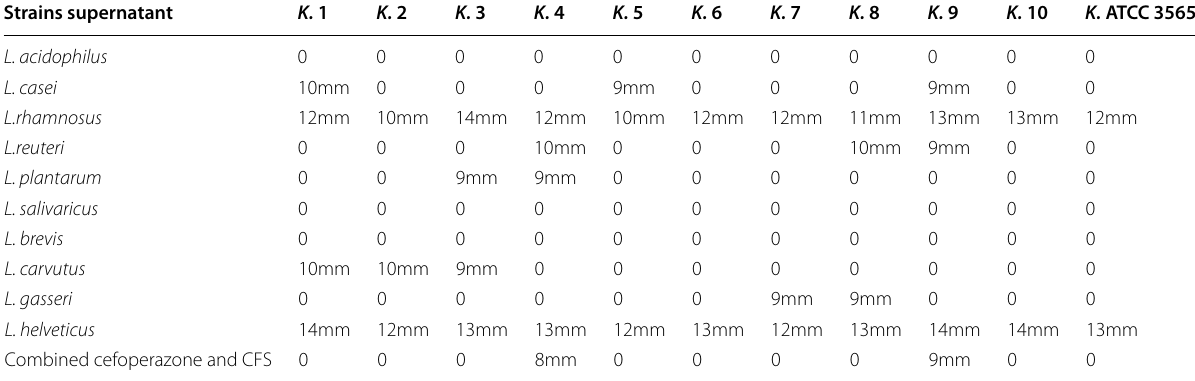
Table 1. Screening of the inhibition zone of growth in (mm) for isolated MDR Klebsiella pneumoniae isolates versus standard strain Klebsiella pneumoniae ATCC 35657 by different probiotic Lactobacilli